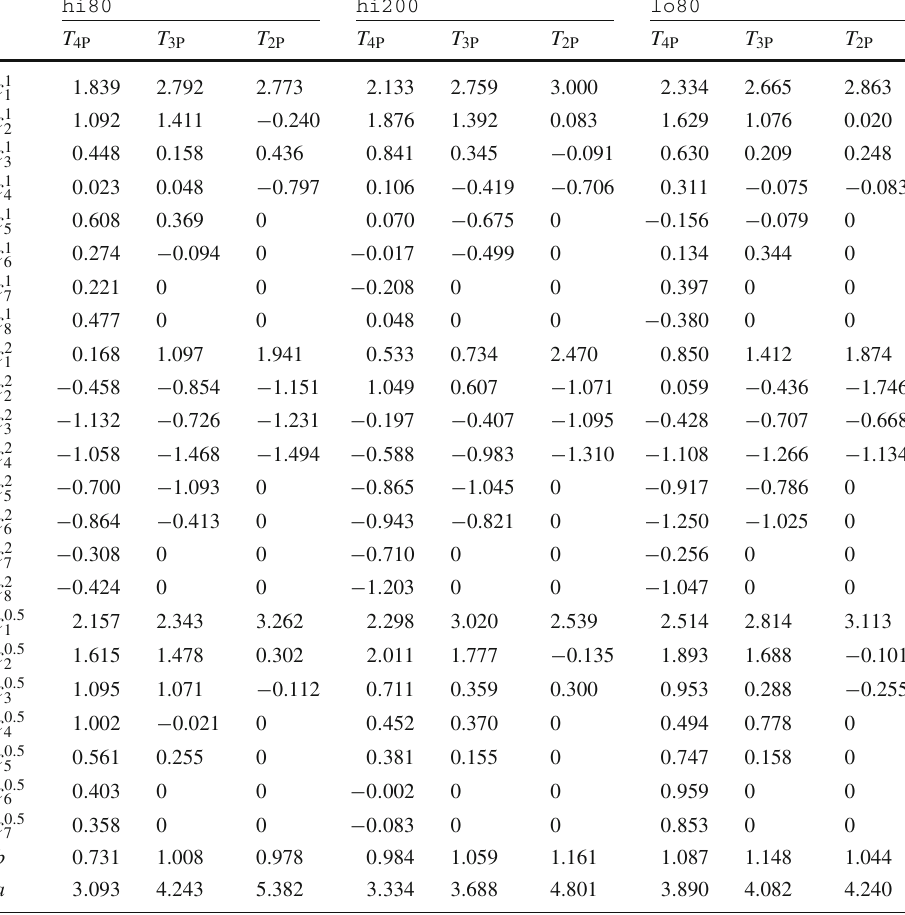
in (3) and (4) corresponding to the different